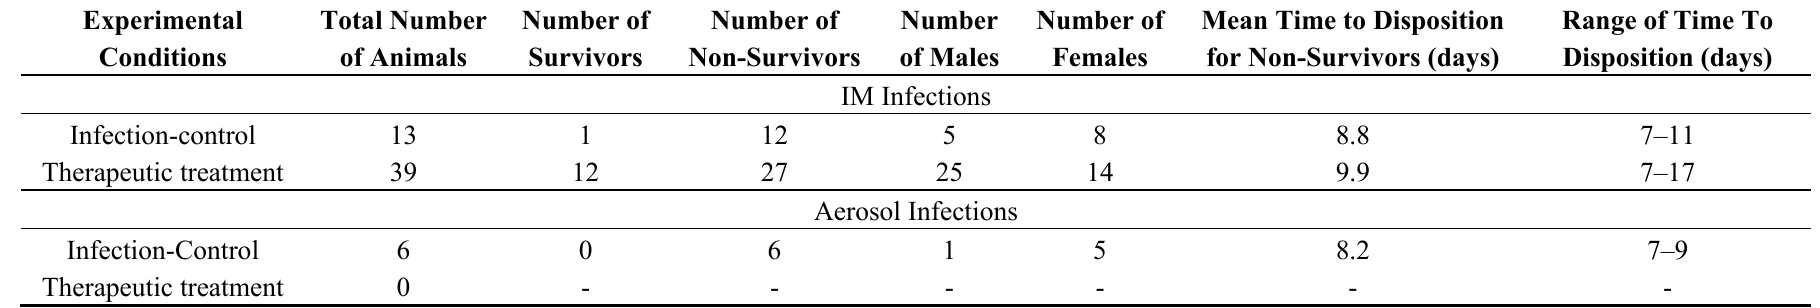
Table 2. Summary of Experimental Conditions and Survival Outcome for Ebola-Virus Infected Rhesus Monkeys.